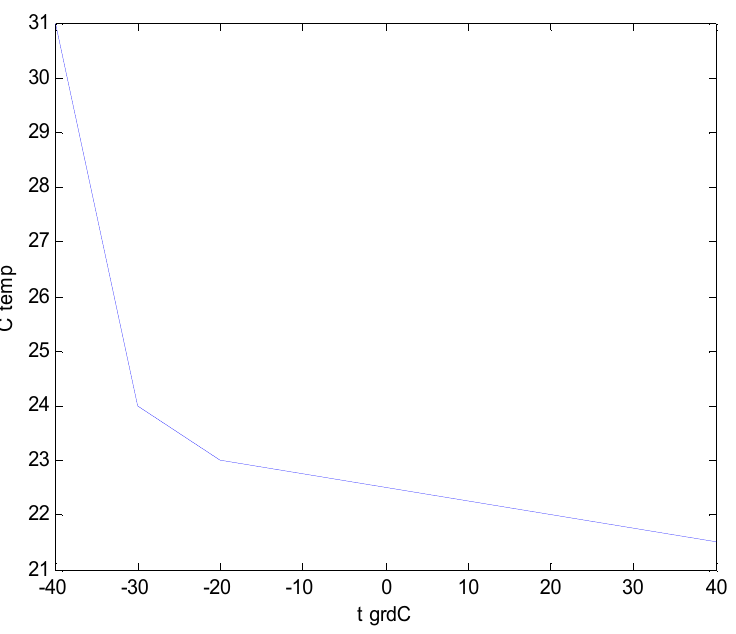
Figure 12 represents the dependency of parameter C temp on the outdoor temperature on the disconnection of a circuit breaker.